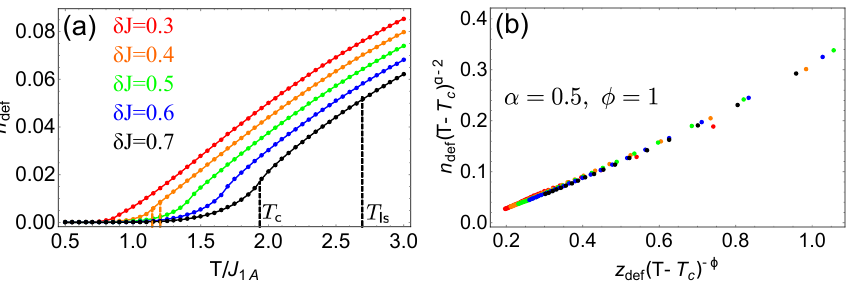
Figure 21: Determination of the Ising to Pokrovsky-Talapov crossover exponent, φ , via scaling of the defect triangle density, n def . (a) n def calculated in the thermodynamic limit for δ J = 0.3 (red) to δ J = 0.7 (black). T δ J = 0.7 (black) and δ J = 0.4 (orange). (b) Scaling of n c and T Is are shown for using Eq. 63 gives good data collapse for α = 1 / 2 and φ =